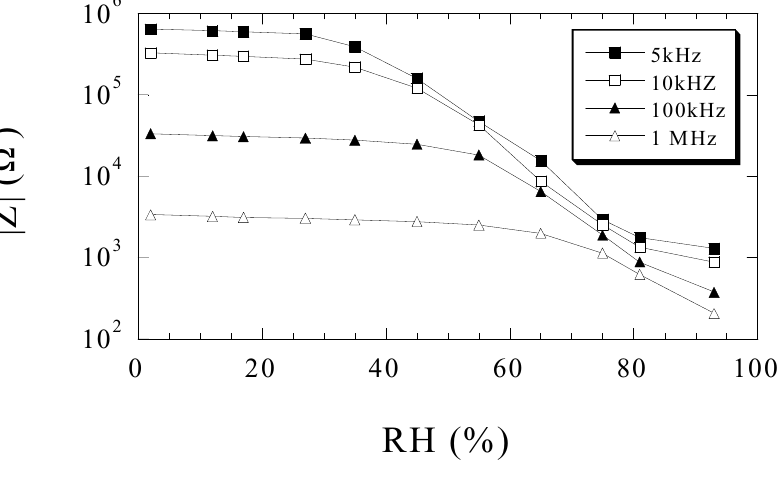
Figure 7. Variation of sensor DS15 impedance with humidity and measurement frequency.